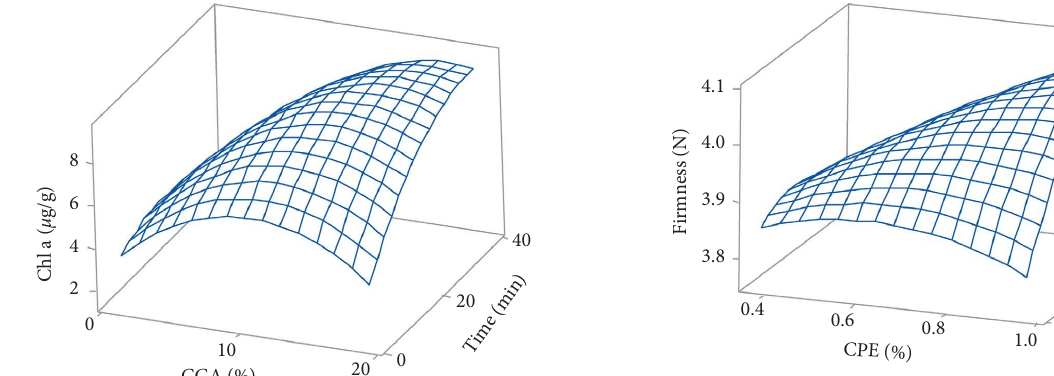
Figure 5: Response surface for frmness of coated tomatoes as function of pineapple peel extract concentration and time of